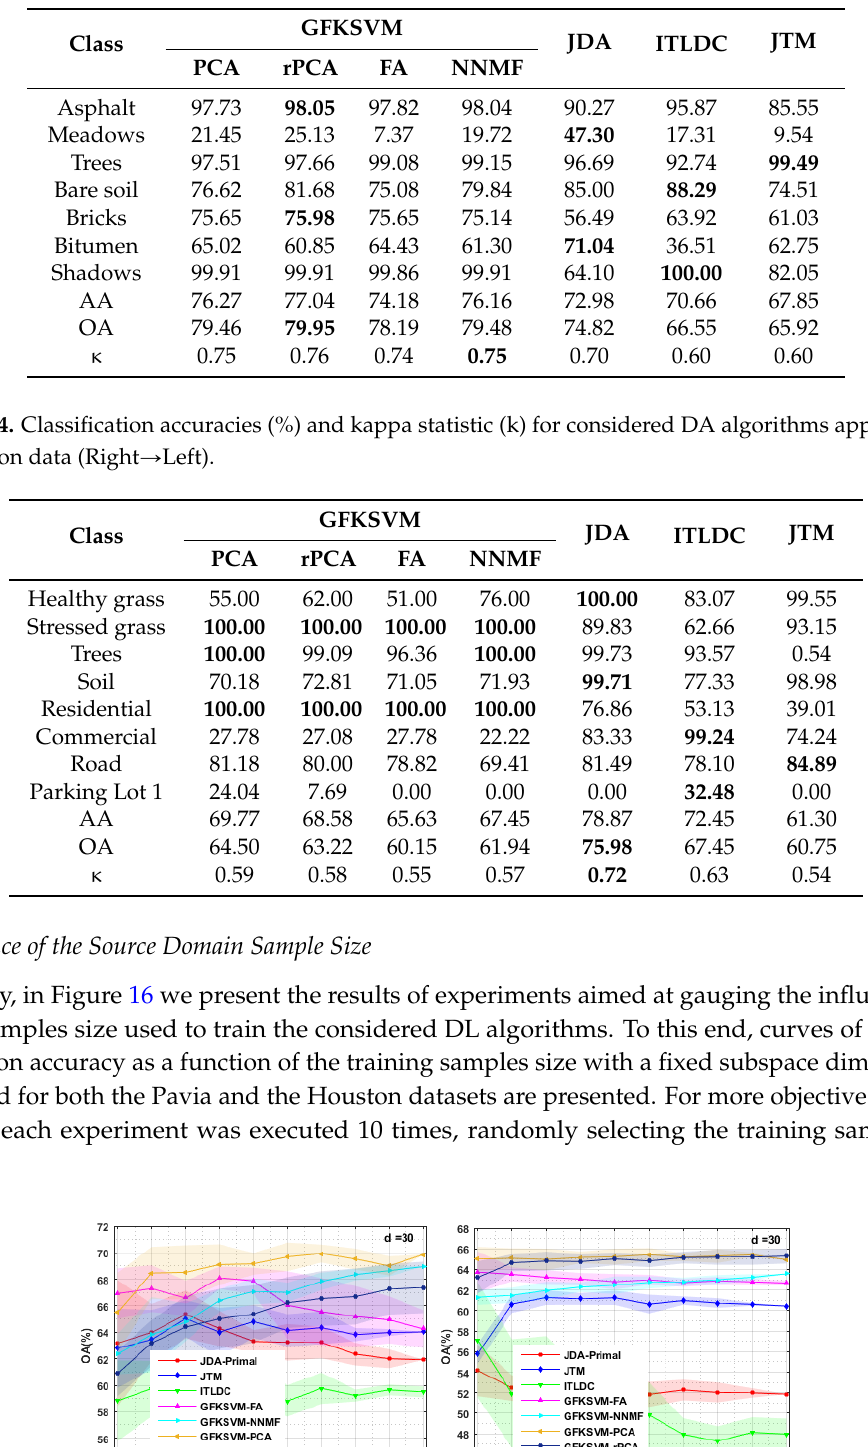
Table 3. Classification accuracies (%) and kappa statistic (k) for considered DA algorithms applied to ROSIS data (University Ñ Center).